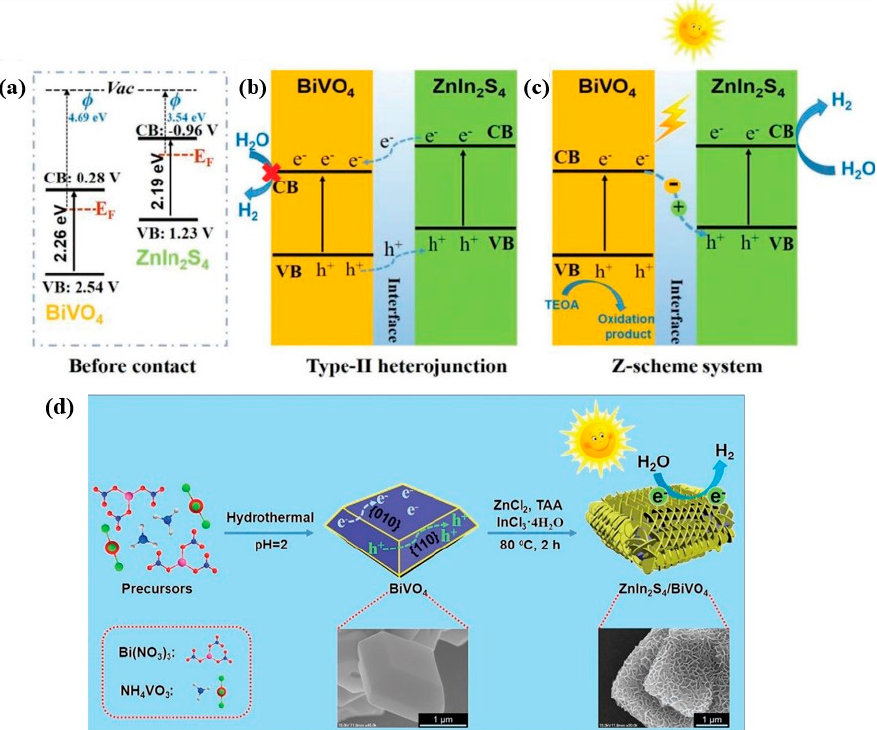
Figure 7. The proposed mechanism of photocatalytic H 2 evolution over ZIS/BVO under visible light irradiation, ( a ) Before contact, ( b ) Type II heterojunction, ( c ) Z-scheme system, and ( d ) Schematic diagram showing the synthesis of ZIS/BVO heterojunction. [Reprinted with permission from refer-